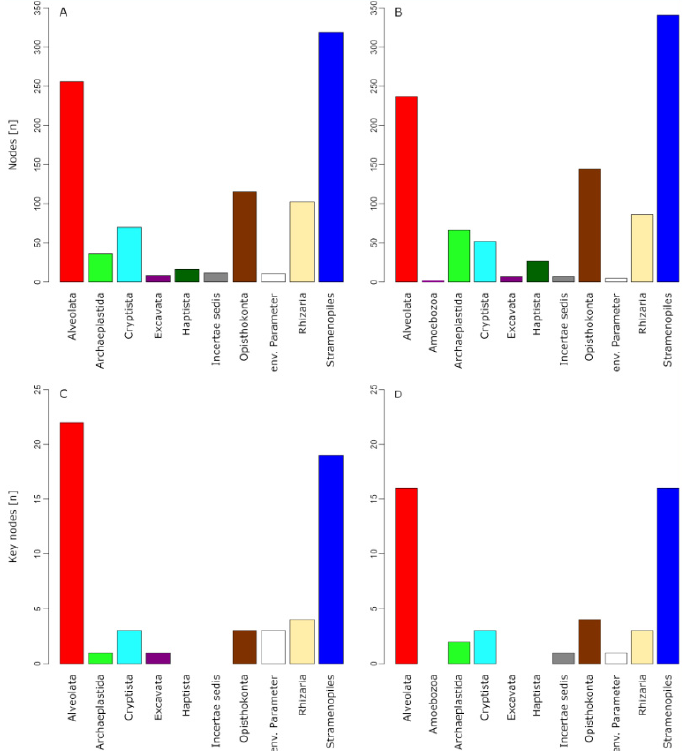
Figure 5. Community composition and key nodes of the co-occurrence networks in both seasons. Taxonomic assignment to higher taxonomic levels follows Adl et al. [62]. Panel ( A ) displays the community composition of the cold season network, panel ( B ) displays the community composition of the warm season network. Panel ( C ) displays the taxonomic affiliation of key nodes in the cold season network, panel ( D ) displays the taxonomic affiliation of key nodes in the warm season network.